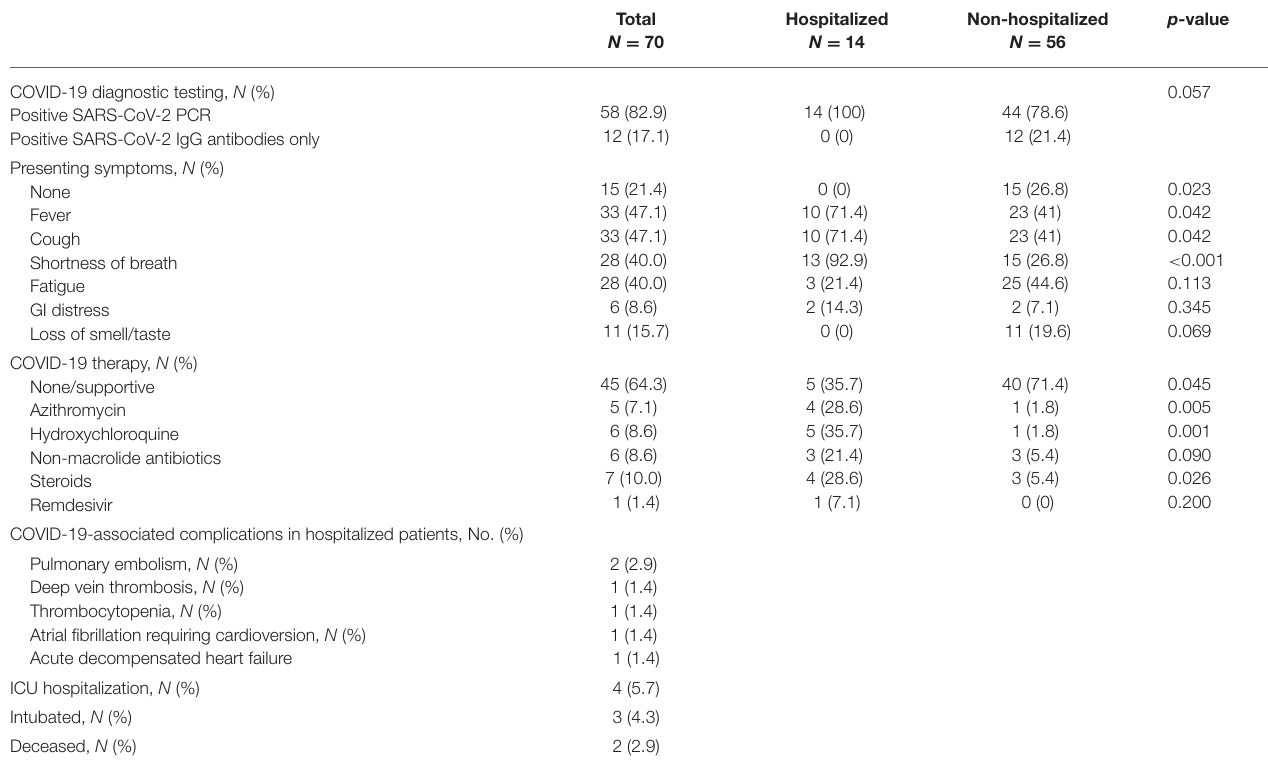
TABLE 3 | COVID-19 symptoms, treatment,